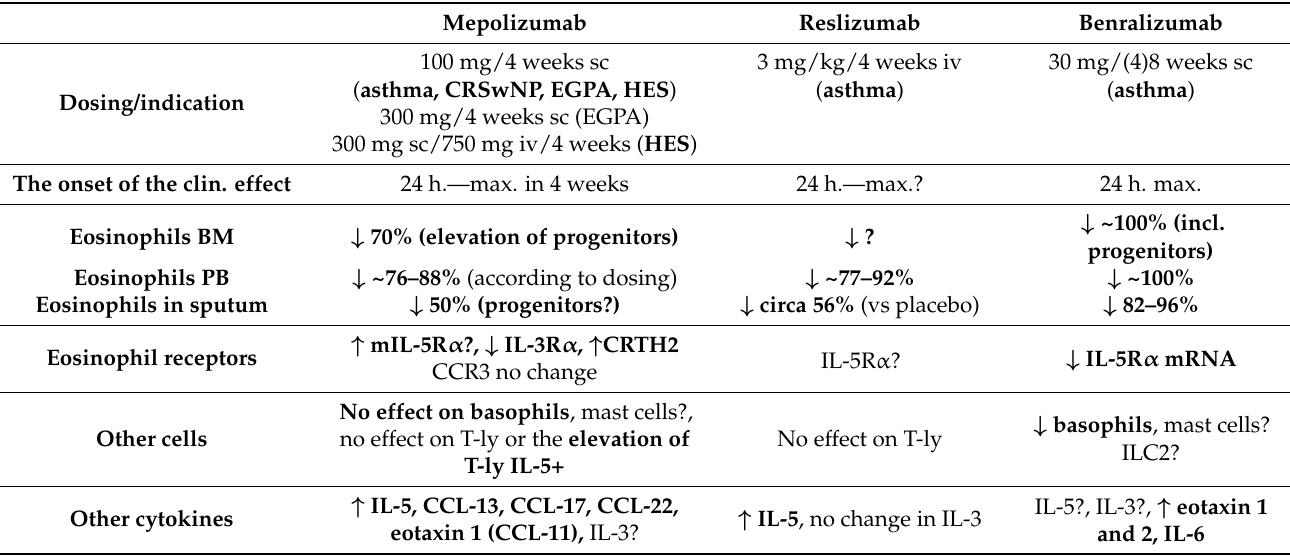
Table 6. Haematological effects of antieosinophil